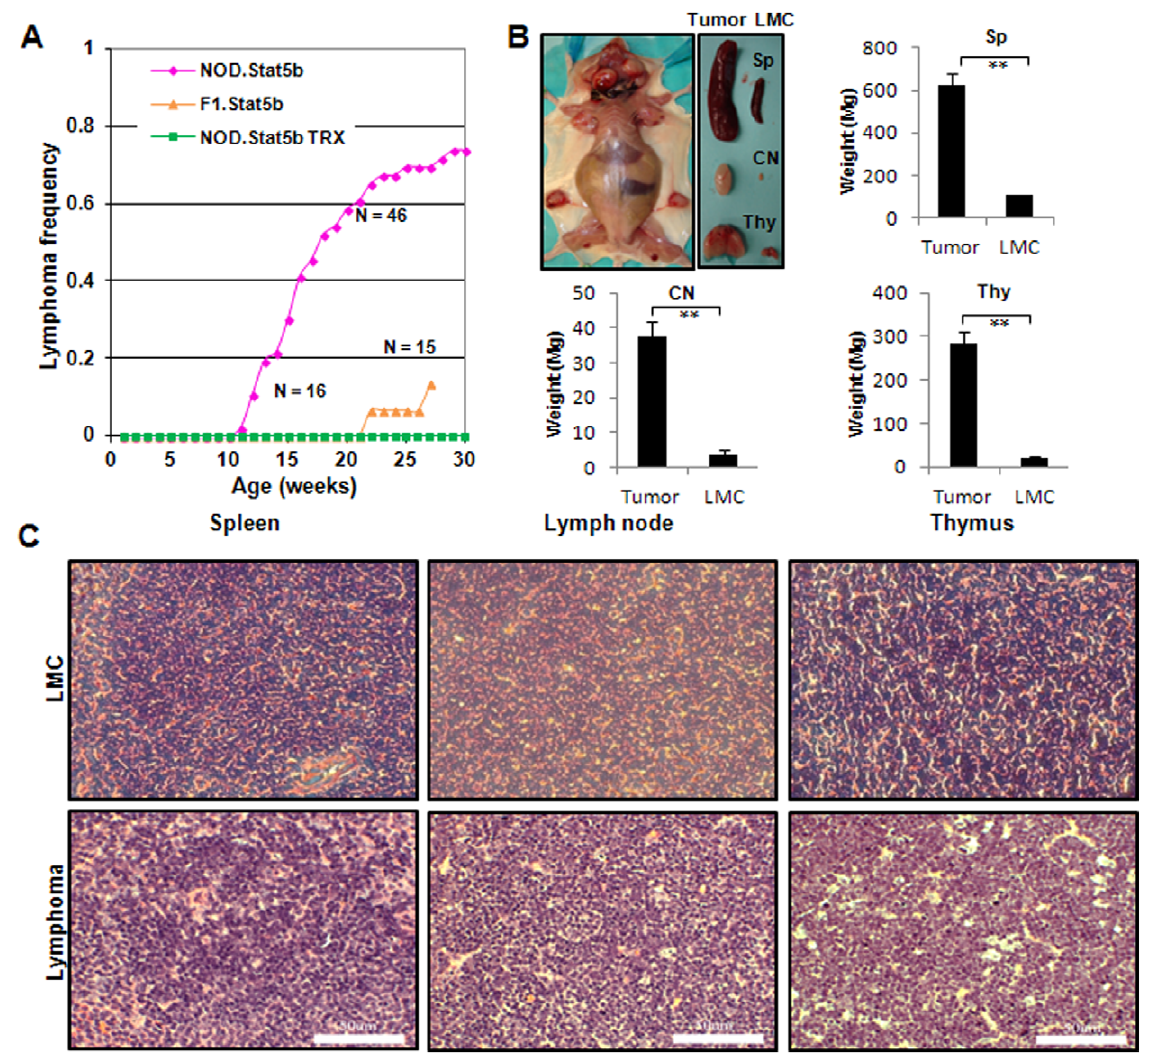
Figure 1. Lymphoblastic lymphoma in Stat5b transgenic mice. (A) Progression of lymphoma observed in the B6xNOD F1.Stat5b Tg mice and NOD.Stat5b Tg mice with or without chemoprevention treatment. The lymphoma incidence is significantly different between F1 mice and NOD.Stat5b Tg mice (p , 0.001). (B) Overview of a mouse that has enlarged thymus, spleen, and lymph nodes (left panel). Enlarged spleen (SP), cervical lymph node (CN) and thymus (Thy) are compared to littermate controls (right panel). **, p , 0.01, compared with that of littermate controls. (C) H&E staining of spleen, cervical node and thymus from a NOD.Stat5b Tg mouse with lymphoma and its littermate control (LMC). Scale bars represent 50 um.